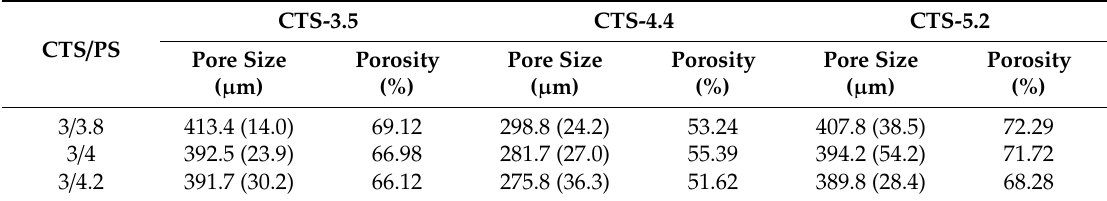
Table 3. The pore size and porosity of foams with CTS solution for 4 wt%.